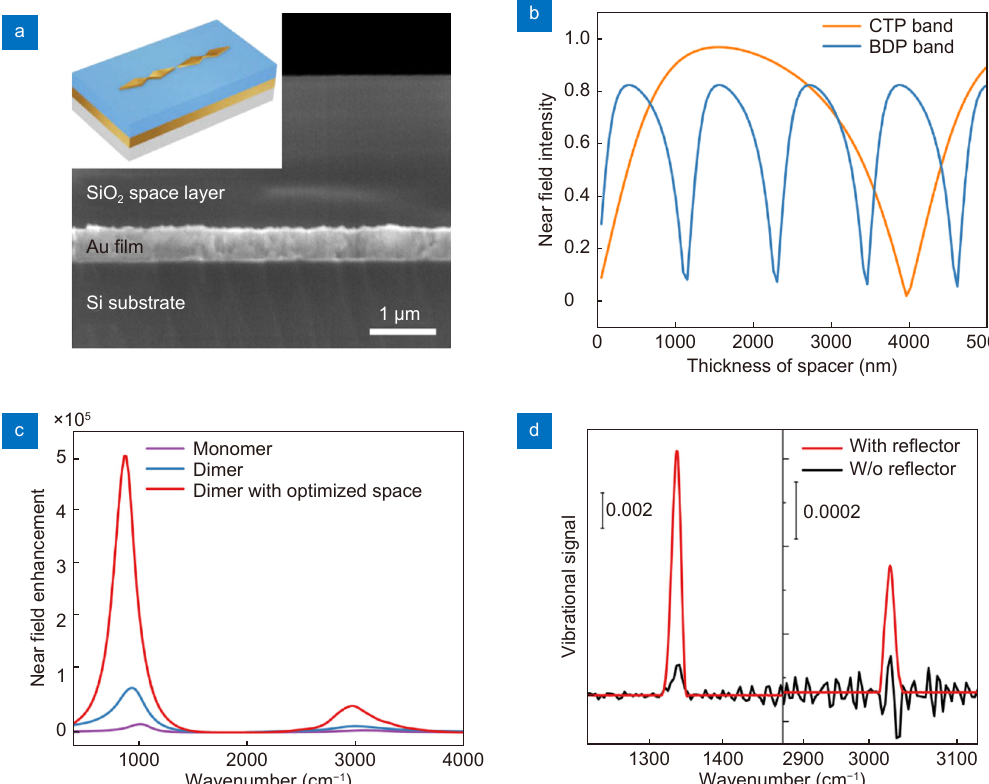
Fig. 7 | ( a ) SEM of the cross section of the reflective substrate. A 200 nm gold film is sandwiched between a 1400 nm SiO 2 spacer layer and the Si substrate. The scale bar is 1 μm. Inset: schematic of the NBRA dimer-on-reflector structure to integrate the waveguide-cavity coupling and nanogap coupling. ( b ) Normalized LFEFs of CTP mode (blue curve) and BDP mode (orange curve) as a function of the thickness of the spacer layer. ( c ) Simulated LFEFs of monomer, dimer and dimer with 1400 nm SiO 2 spacer layer. ( d ) SEIRA spectra of PNTP on NBRA dimer on trans- mitted substrate or on reflective